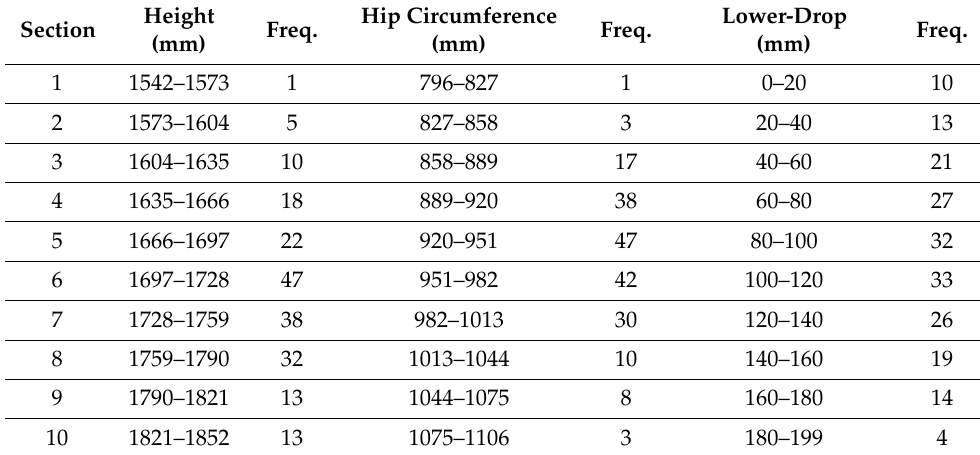
Table 4. Division of important variable section.